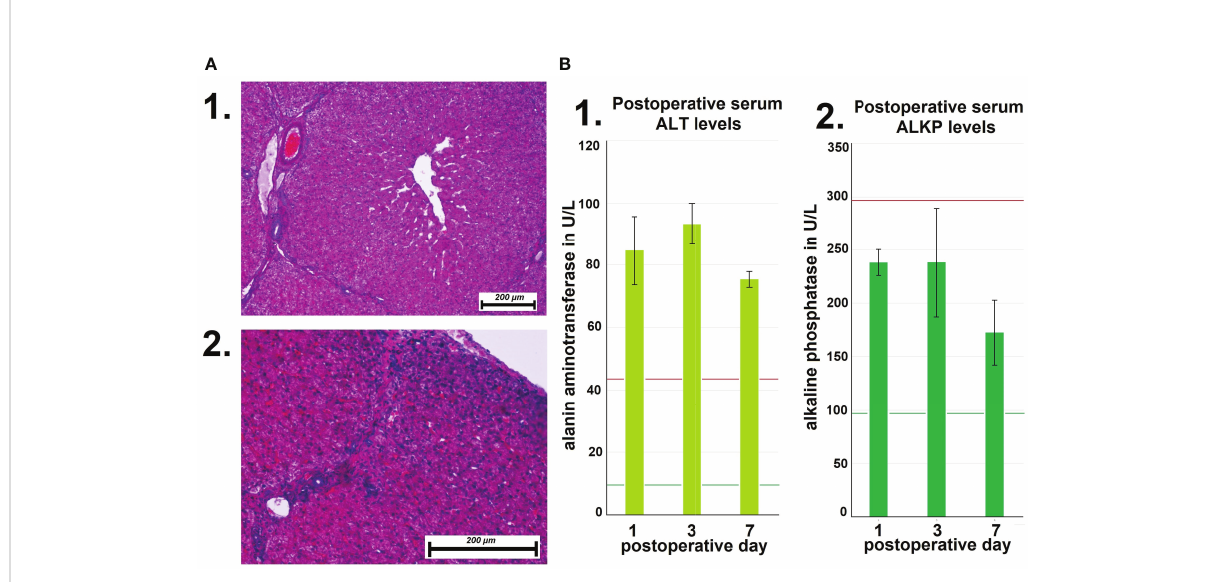
FIGURE 5 (A) Microscopic changes of liver tissue following high- fl ow gas-based hyperthermia. 1. Deep tissue samples from the liver without pathologies. 2. Vascular clotting in capillaries close to the liver capsule. (B) Mean postoperative serum levels of alanin aminotransferase (ALT) at day 1, 3 and 7. Mean postoperative serum levels of alkaline phosphatase (ALT).